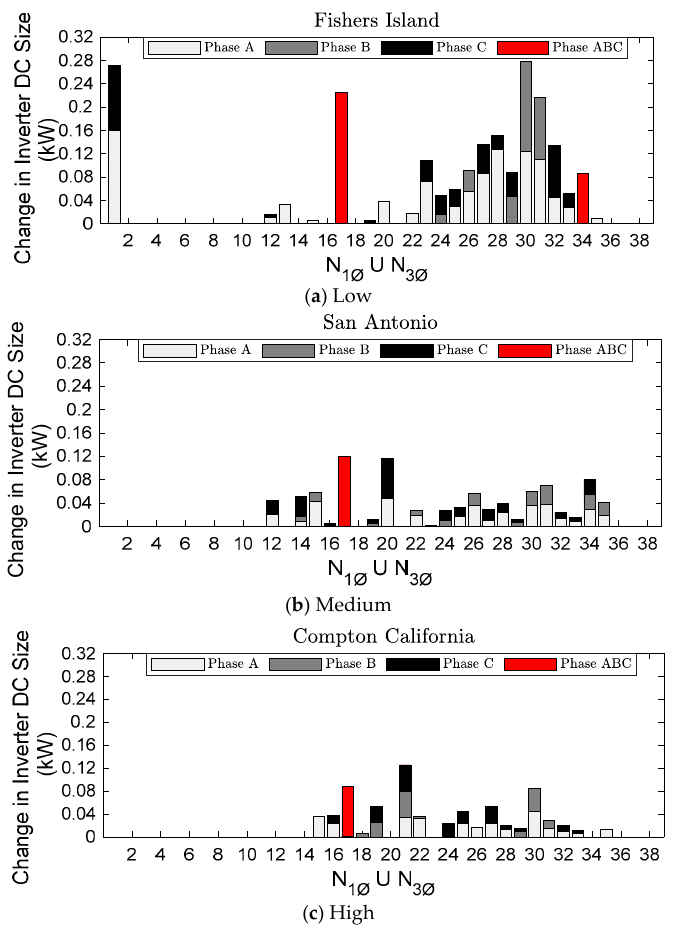
Figure 5. PV inverter placement and size with load change by +40% in all phases.